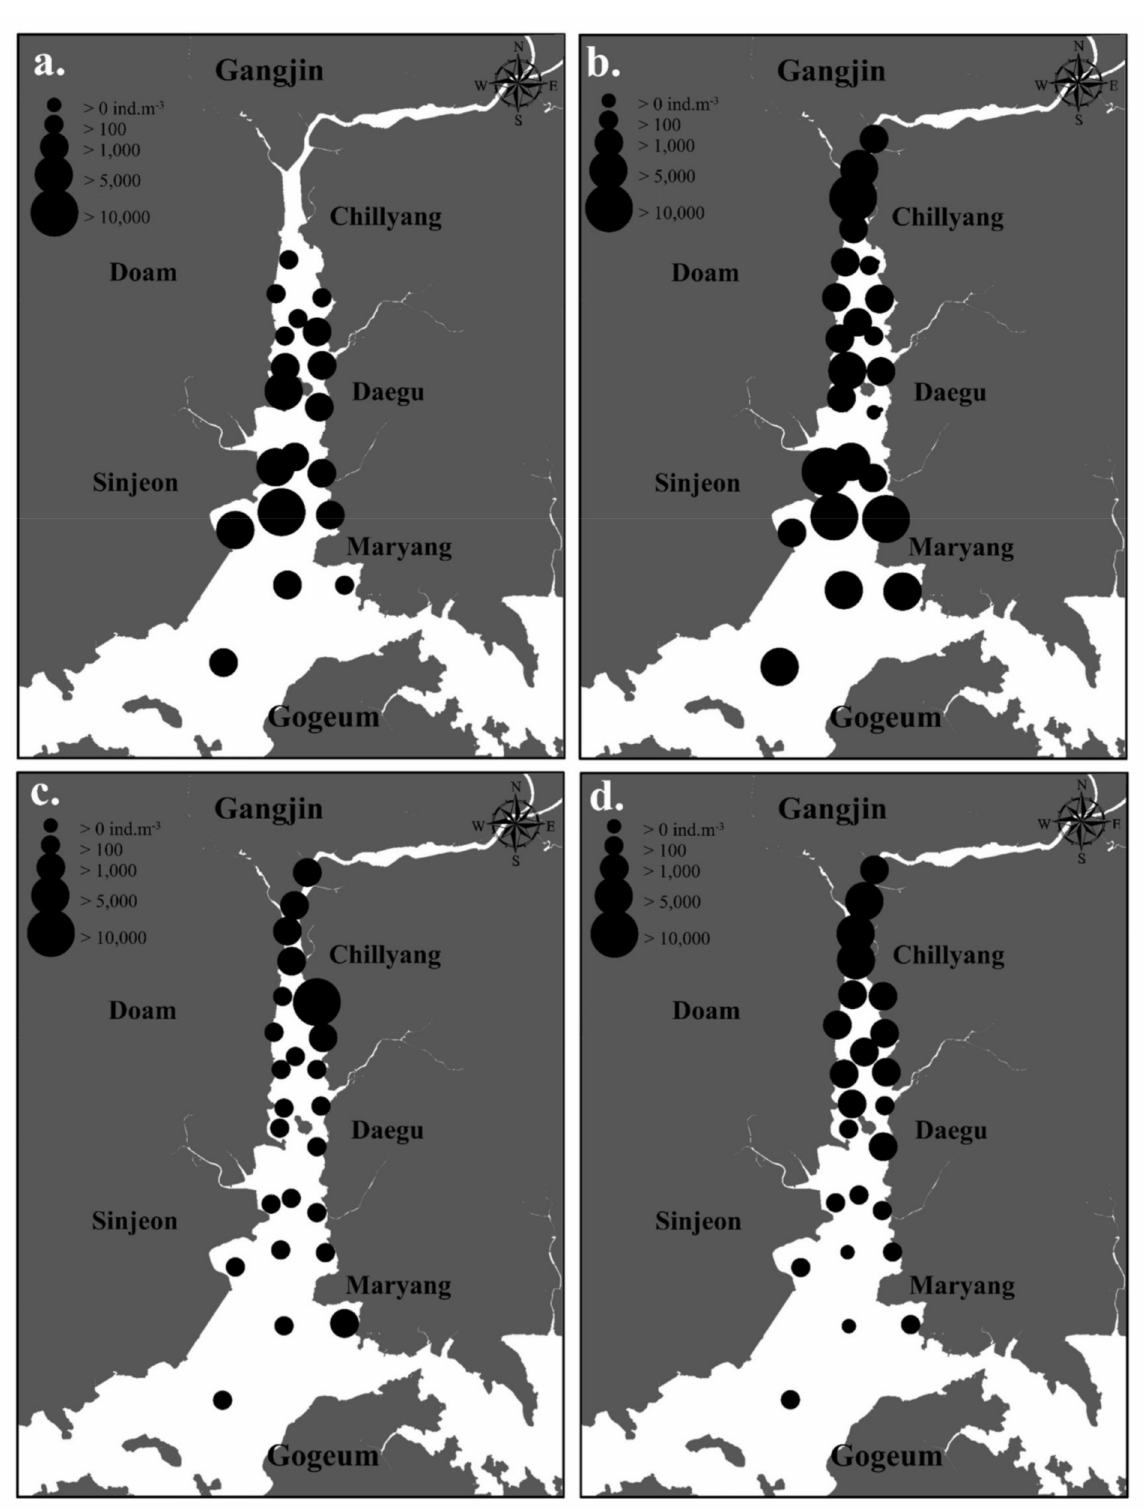
Figure 6. Horizontal distribution of zooplankton abundance (ind./m 3 ) during the study period: ( a ) spring, ( b ) summer, ( c ) fall, ( d )